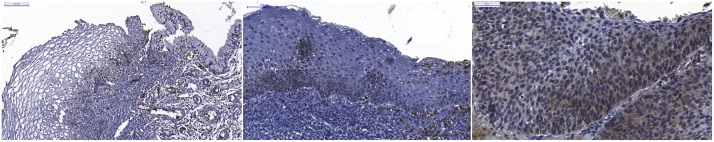
Immunohistochemical staining of RAP1.Left—Squamocolumnar junction of non-dysplastic cervical mucosa (NDM) showing very weak immunostaining for RAP1 in the cytoplasm of basal cells and no staining in the intermediate and superficial cells. Middle—CIN 1 showing moderate staining for RAP1 in cells distributed in the basal third of the epithelium and showing RAP1 expression in neutrophils. Right- CIN 2/3 showing strong staining for RAP1 in cells diffusely distributed throughout the entire epithelial thickness, with nuclear translocation of RAP1.